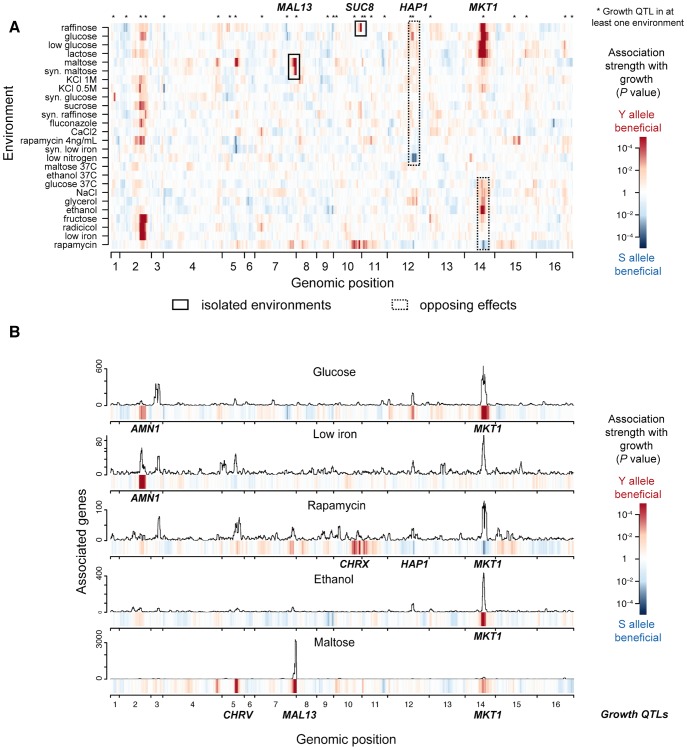
Genetic architecture of growth rate and gene expression in multiple environments.(a) Genetic associations with growth (growth QTLs) in 26 environmental conditions. The significance of association (P-value, single-marker analysis, Methods) is shown for each of 13,314 markers along the genome (x-axis) with growth rates in 26 environments (y-axis). The direction of the QTL effect is color-coded, where red indicates that the clinical isolate (Y) allele is associated with increased growth rate and blue the lab strain (S) allele; darker colors indicate greater significance. Two examples of markers significantly associated with growth in only a small number of environments (MAL13 and SUC8, black rectangles), and two showing significant effects in opposing directions depending on environment (HAP1 and MKT1, dotted black rectangles) are highlighted. (b) Genetic associations with gene expression (eQTLs) in 5 selected environments. Each panel shows the number of genes associated with the underlying regions in a sliding window analysis for each environment (FDR<0.05, 50 kb window). The association strength of growth from a) is displayed in the color bars below each panel. Six significant genetic loci were identified that jointly regulate growth in these environments (AMN1, CHRV, MAL13, CHRX, HAP1, MKT1, multi-environment growth genetic model, Methods). These are labeled in bold for every environment in which they were associated with growth in (a) (growth QTL).